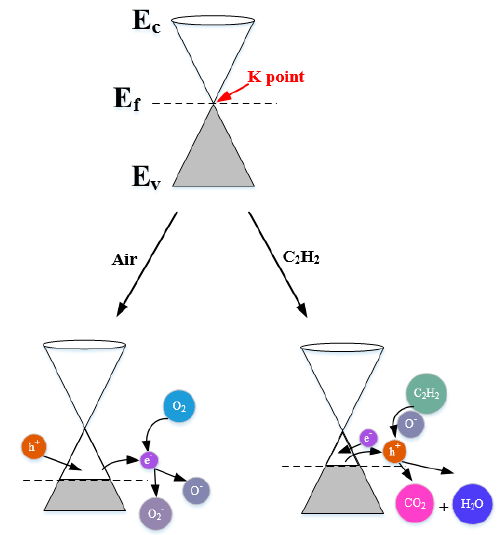
Figure 14. Energy band models for C 2 H 2 gas sensing mechanisms of pure rGO nanosheets.